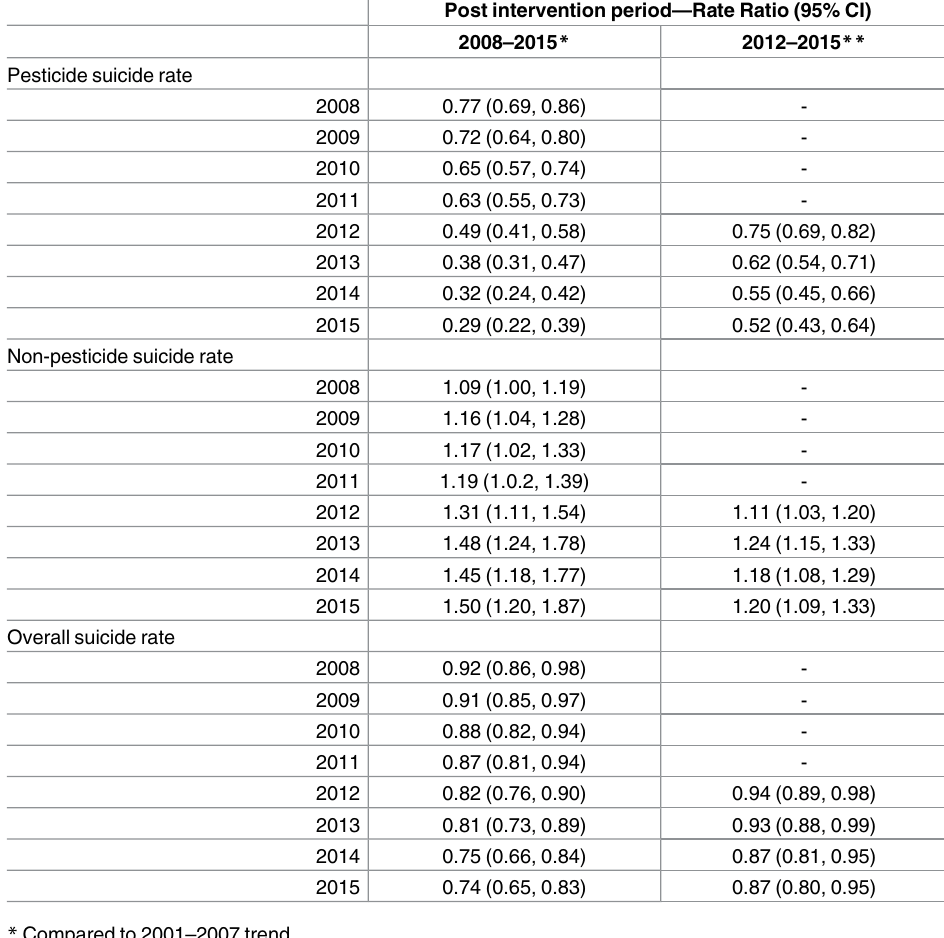
Table 2. Sensitivity analysis changing the post-intervention period from 2011–2015 to 2008–2015and